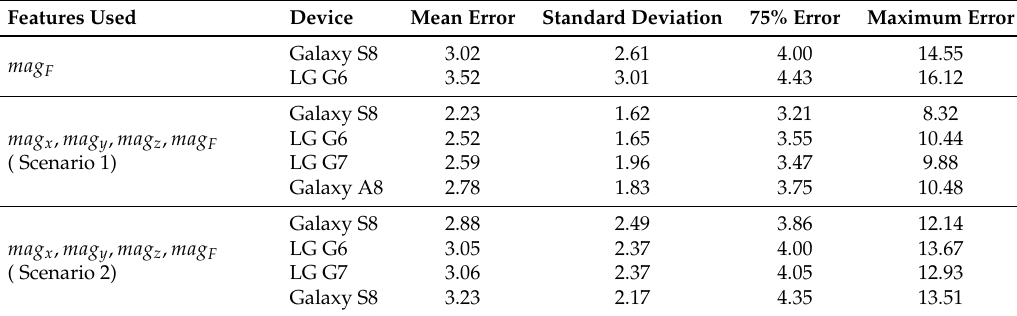
Table 2. Results statistics for single vs. multiple features based